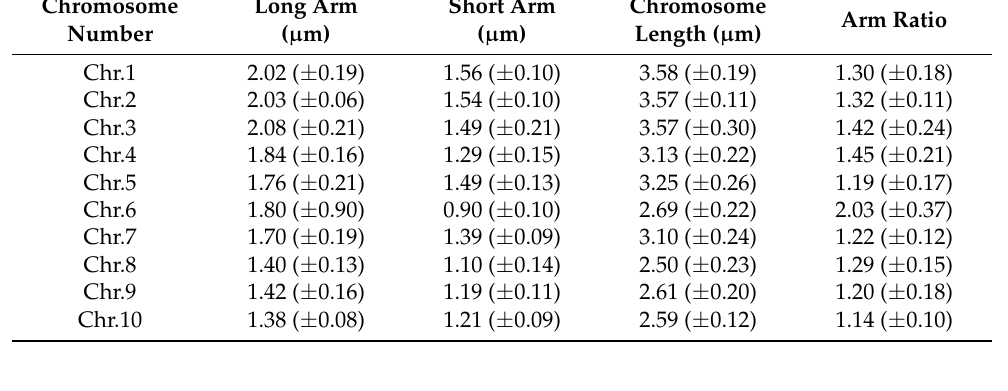
Table 2. Chromosome length and arm ratio of mitotic metaphase chromosomes of T. arundinaceum.